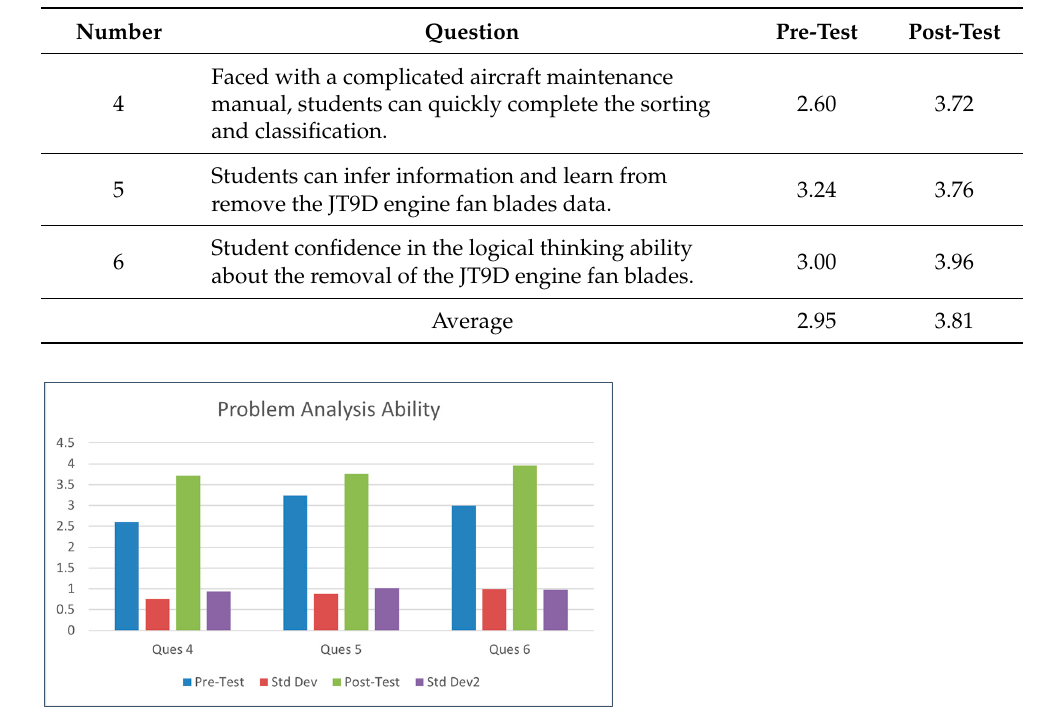
Table 4. The results for the problem analysis ability.